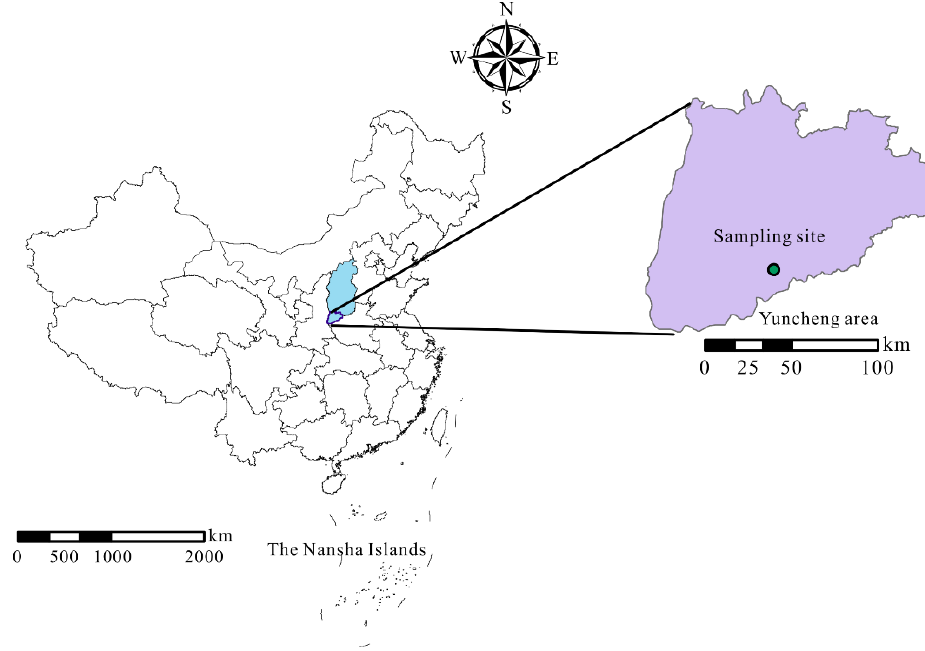
Figure 1. Locality map showing the sampling site in the Yuncheng area, Shanxi Province.